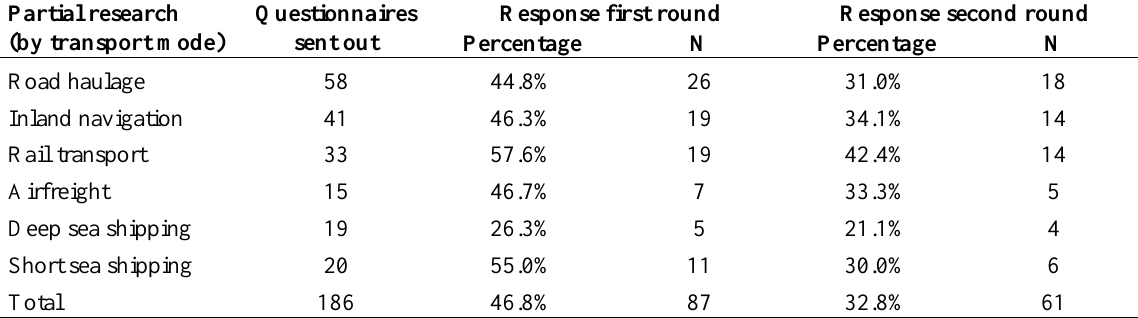
Table 4. Response